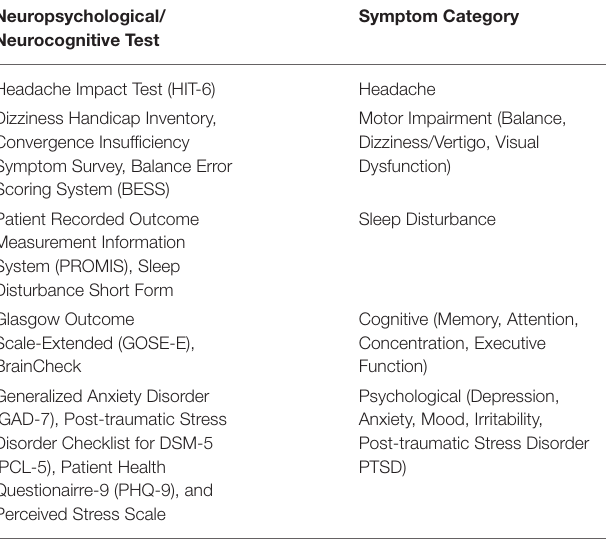
TABLE 3 | Symptom categories with corresponding neurocognitive and neuropsychological tests. Neuropsychological/ Neurocognitive